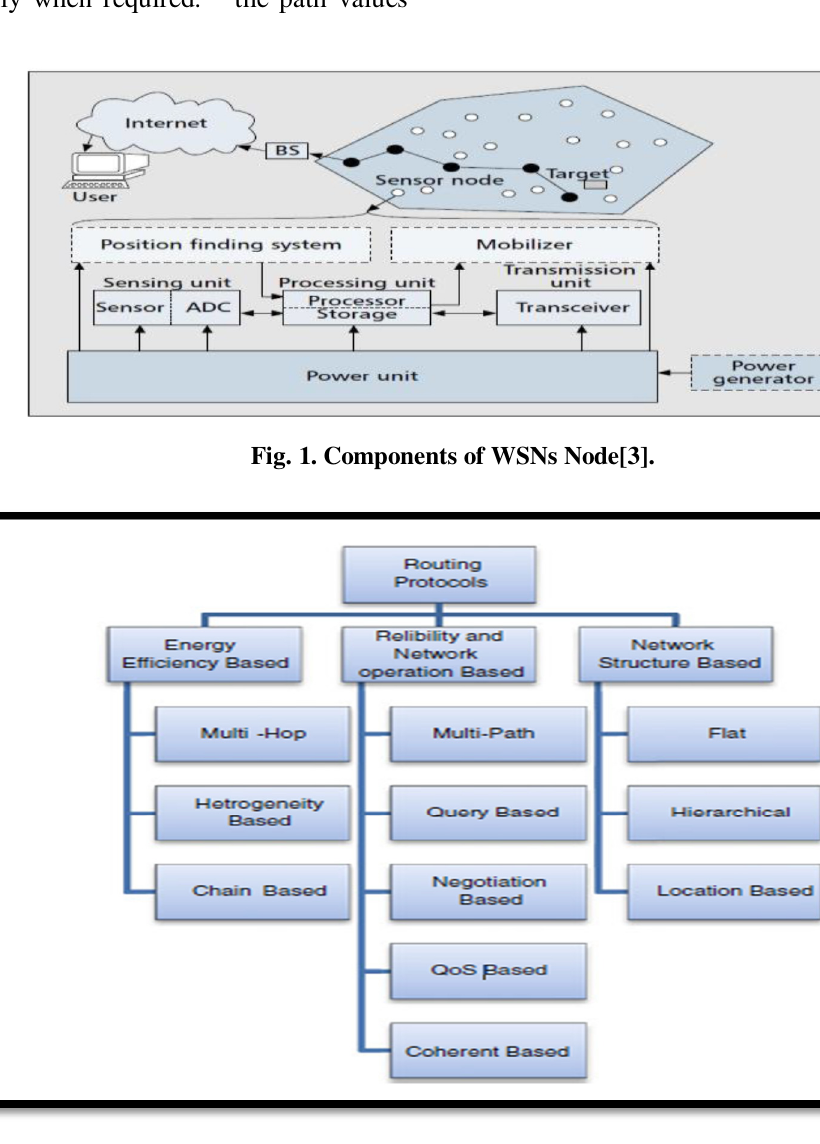
Fig. 2. General classification of Routing protocols in WSNs[6,